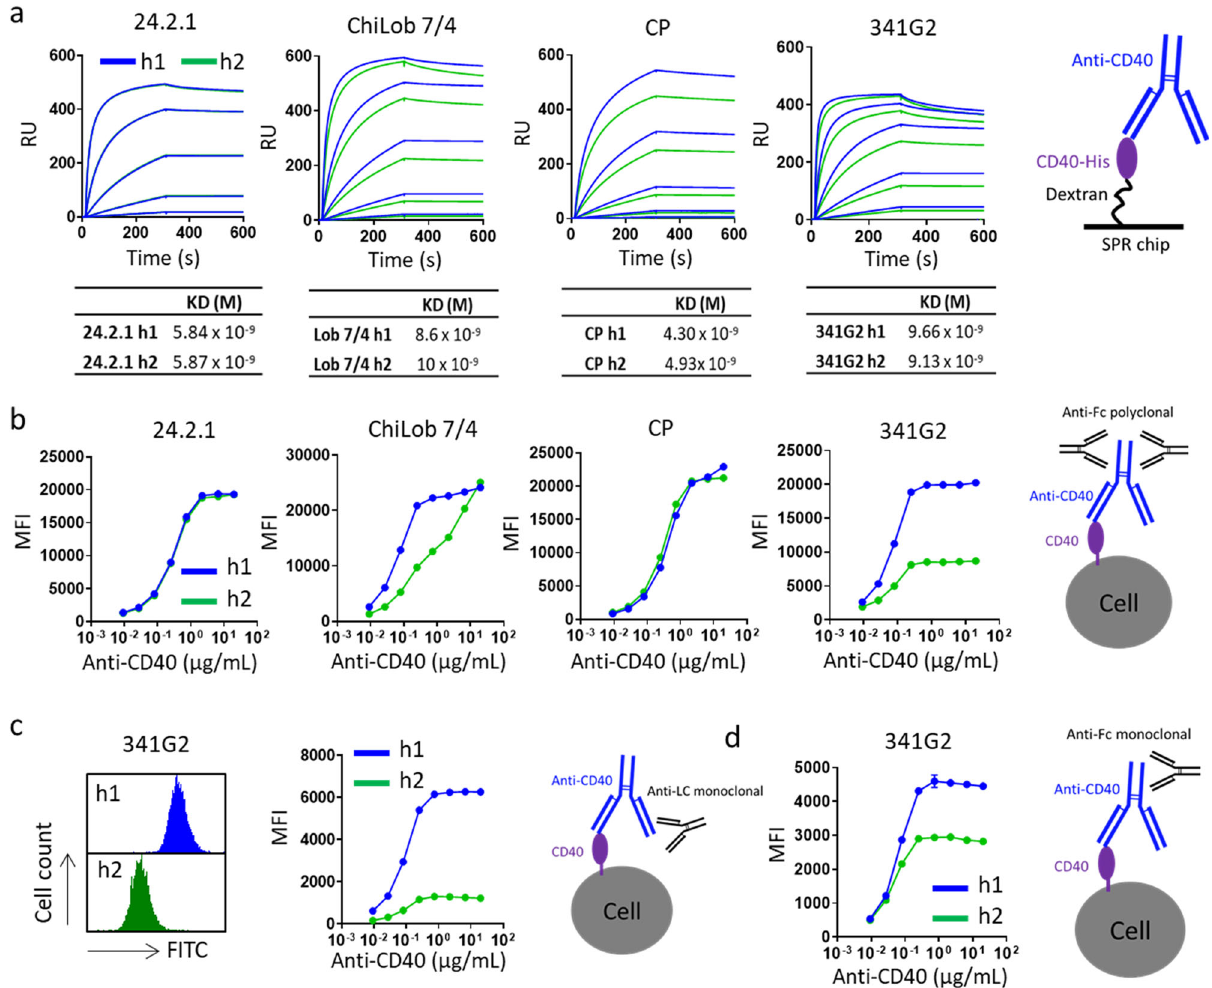
Fig. 4 Differential receptor binding by anti-CD40 hIgG1 and hIgG2. a Recombinant hCD40ECD was immobilised onto CM5 chip via amine coupling and various anti-CD40 mAbs as h1 or h2 were injected at 250, 50, 10, 2, 0.4, and 0 nM using a Biacore T200 instrument. Both association phase and dissociation phase lasted 300 s. KD values were calculated using Biacore Bioevaluation software and values represent the mean from three independent experiments. b Ramos cells were incubated with various anti-CD40 mAbs as h1 or h2 as indicated and then washed and bound hIgG was detected by polyclonal anti-human IgG Fc, c monoclonal anti-human kappa light chain (left panel histograms represent cell surface binding of 341G2 h1 or h2 at 20 µ g/ mL) or d monoclonal anti-hIgG Fc. Means ± SEM, n = 3, data representative of independent 3